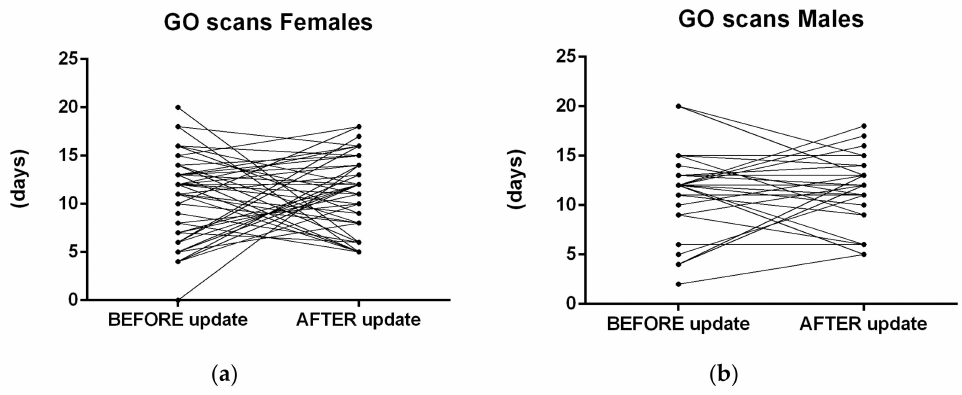
Figure 14. Differences before and after the app update in GO Dental monitoring scans were not significant ( a ) in females (insignificant) ( b ) Males